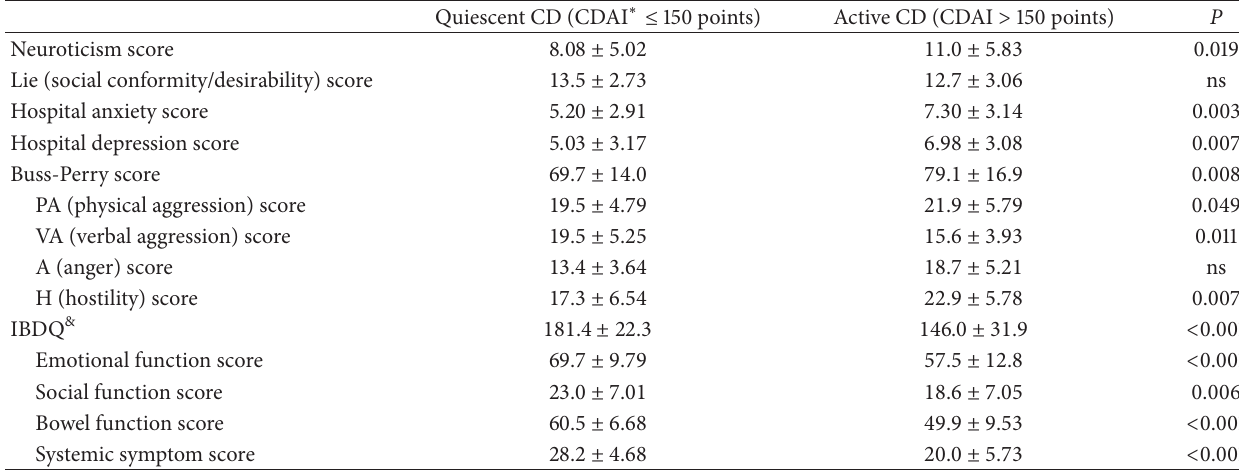
Table 3: Psychological variables and HRQoL in patients with Crohn’s disease.